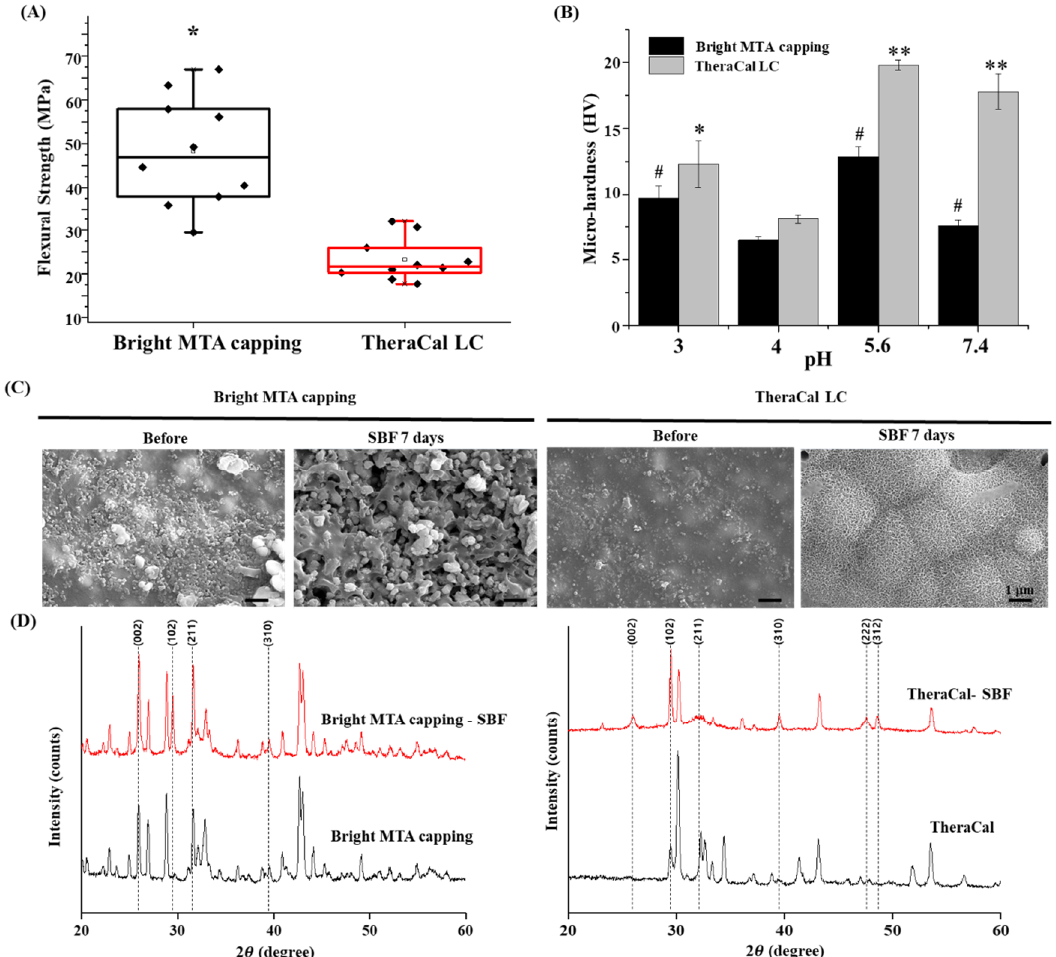
Figure 4. Mechano-physical properties of nanoparticle-incorporated, light-curable MTA. ( A ) Vickers hardness measured in five spots per specimen and averaged (n = 10). Asterisks (*) indicate statistical significance between bright MTA and TheraCal LC at the same pH ( p < 0.05). Different letters indicate statistical significance between bright MTA and TheraCal LC at the same pH ( p < 0.05). This test attempted to simulate the actual clinical environment during inflammation. ( B ) Three-point flexural strength (n = 10). There was a statistical difference between bright MTA and TheraCal LC. The (#) symbol and asterisks (*) indicate bright MTA capping and TheraCal LC’s statistical significance based on the lowest value of micro-hardness (* p < 0.05, ** p < 0.01) (pH = 4). ( C ) Surface morphology of bright MTA and TheraCal LC immersed in SBF solution for seven days, as visualized by scanning electron microscopy ( × 10,000) (scale bar = 1 µ m). The SBF solution can mimic the main features of blood serum; thus, using the SBF solution can test bioactivity. ( D ) XRD analysis of specimens immersed in SBF for seven